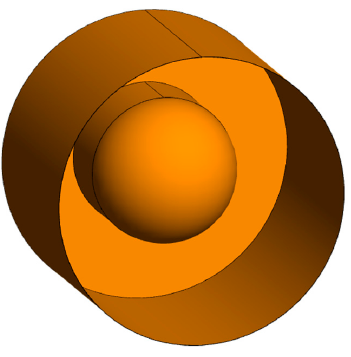
Figure 4. Complex cylindrical cavity. Table 3. Dimensions of the complex cylindrical cavity.